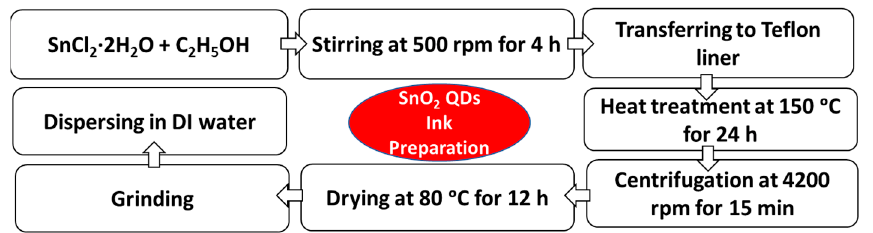
Figure 1. Preparation of ETL ink with SnO 2 QDs.